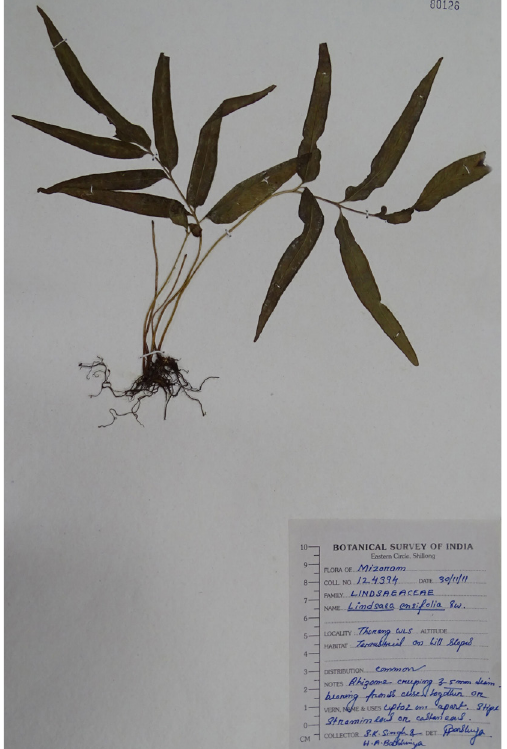
Image 19. Pteridium revolutum Image 20. Lindsaea